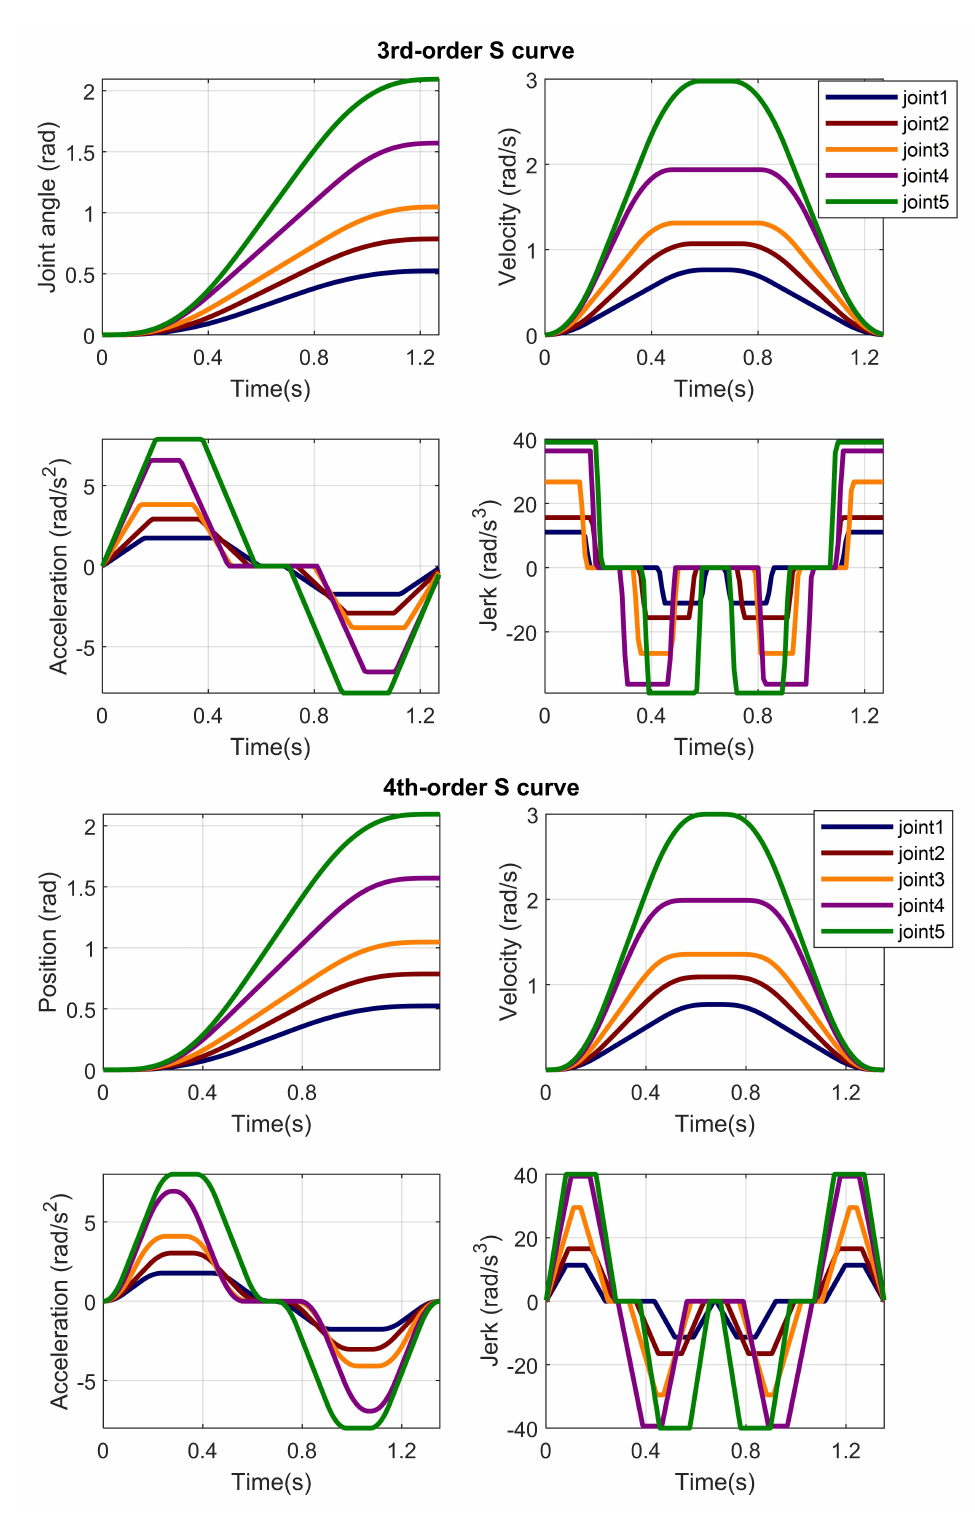
Figure 8. Comparison of planned trajectory for the five-DOF manipulator in terms of the motion profiles in the joint